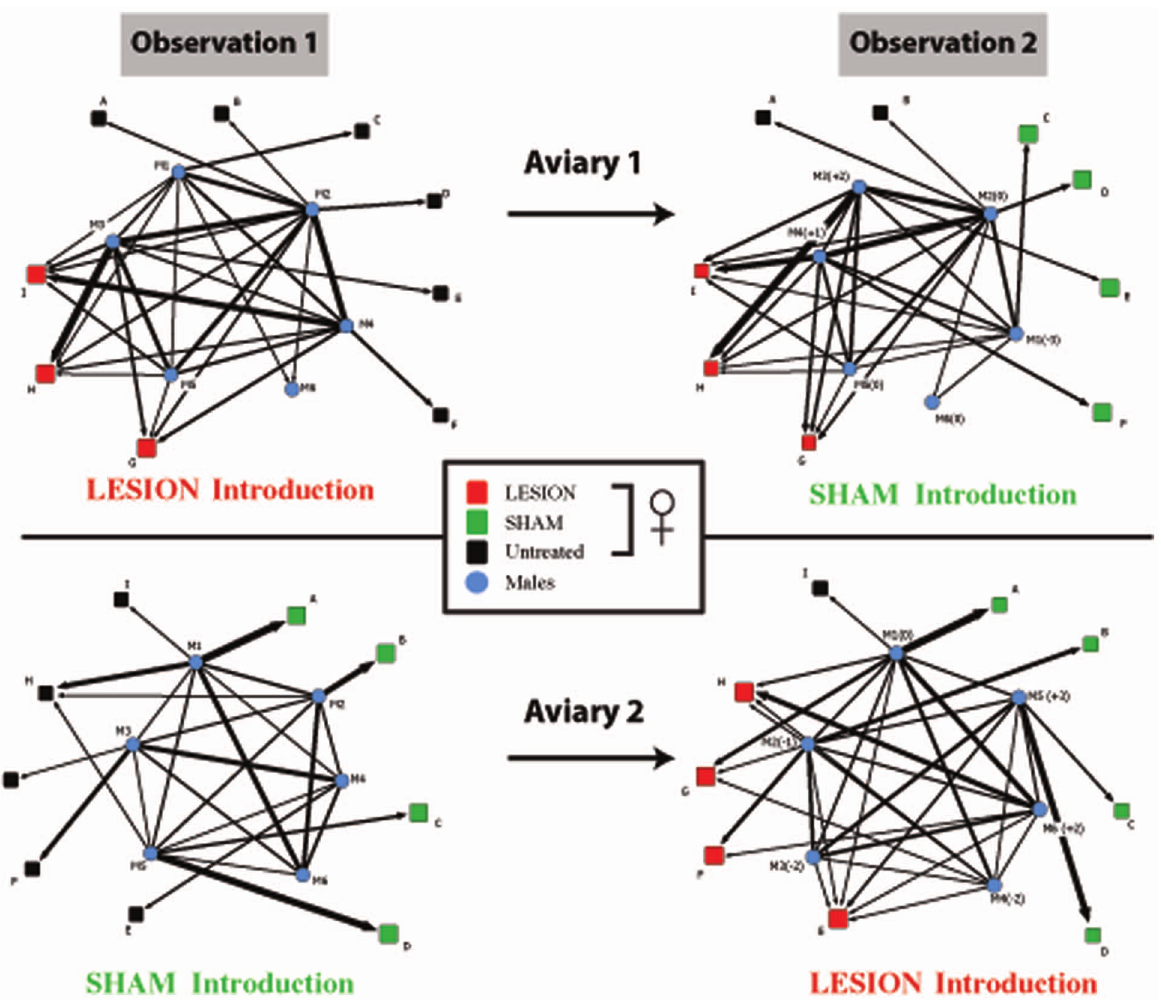
Figure 4. Lesioned females destabilize the social network of mixed-sex flocks. Social network structure for each observation session in experiment 2. Lines represent directed singing interactions. Letters/numbers beside nodes represent individual identity, (females: squares males: circles). Vertical spacing of males represents relative dominance rank based on male-directed singing ratio. Numbers beside males in parentheses represent change in dominance rank from the observation session before the one shown. Thickness of the line represents number of songs sung (largest line =208 songs [aviary 2, lesioned introduction, M1 to A], smallest =5 songs [multiple instances]). Arrows represent direction of singing interaction.